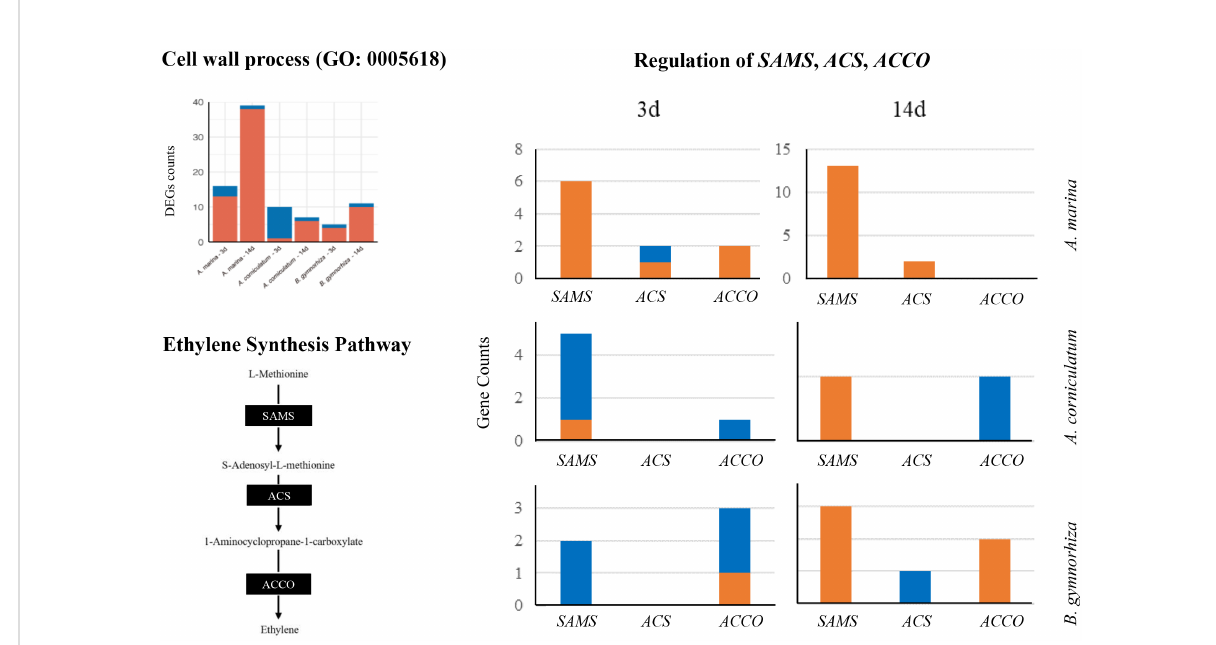
FIGURE 7 Differentially expressed genes (DEGs) counts of the cell wall process (GO: 0005618), ethylene synthesis pathway, and regulation of SAMS , ACS , and ACCO